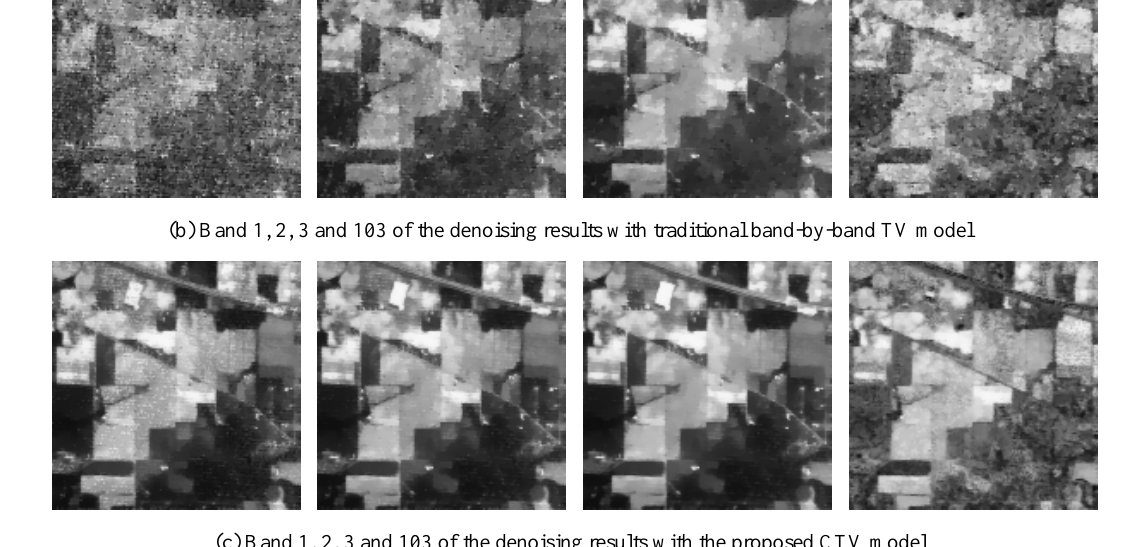
(c) Band 1, 2, 3 and 103 of the denoising results with the proposed CTV model Fig. 2 The denoising result of Indian